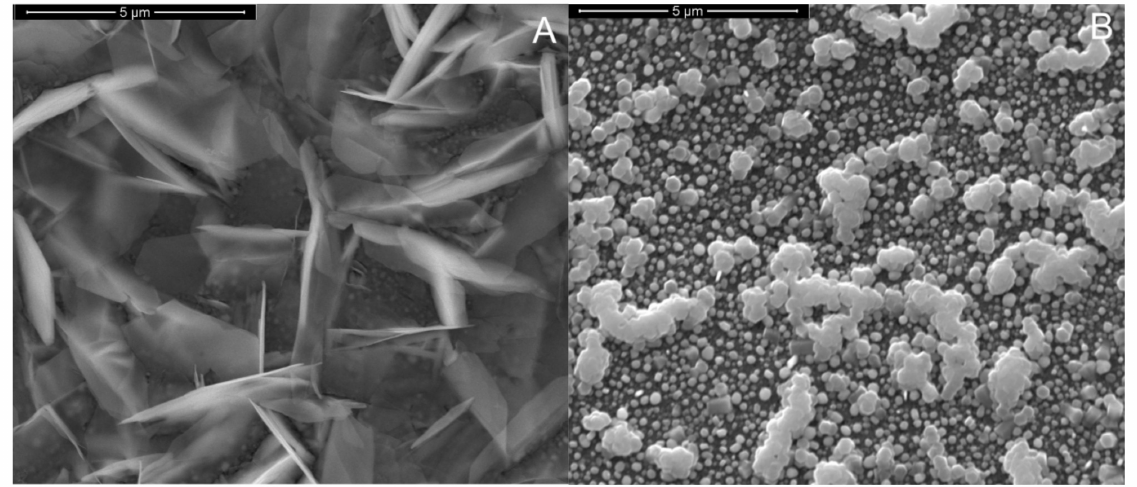
Figure 2. SEM images of samples obtained using a solution of 10 mM ZnCl 2 + 10 mM NaNO 3 at 60 ◦ C for 180 min at applied potential − 1 V ( A ) with saturated dissolved oxygen and ( B ) following N 2 purge